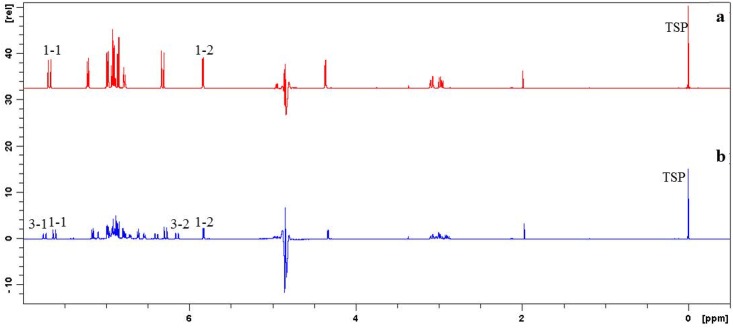
1H NMR spectra of LA.(a) and degraded sample heating 5h in Exp. No. II (b).